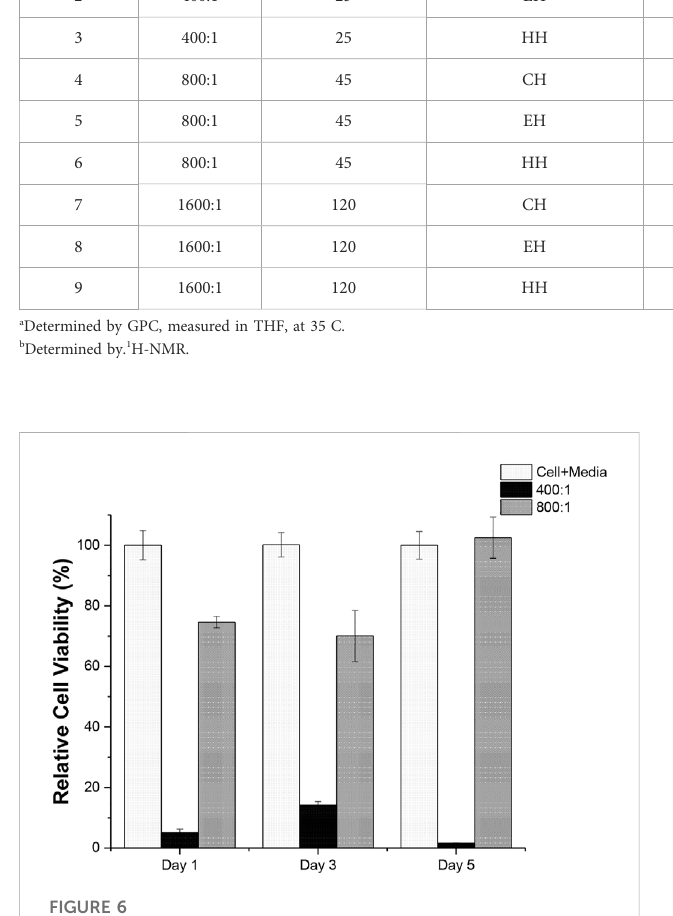
FIGURE 6 Percent cell viability of Panc02 cells at day 1,3, and 5 (n = 5) for Cell + Media sample and PCL polymer produced with [M]:[C] ratio of 400: 1 and 800:1. Values are expressed as relative % viability; mean ±